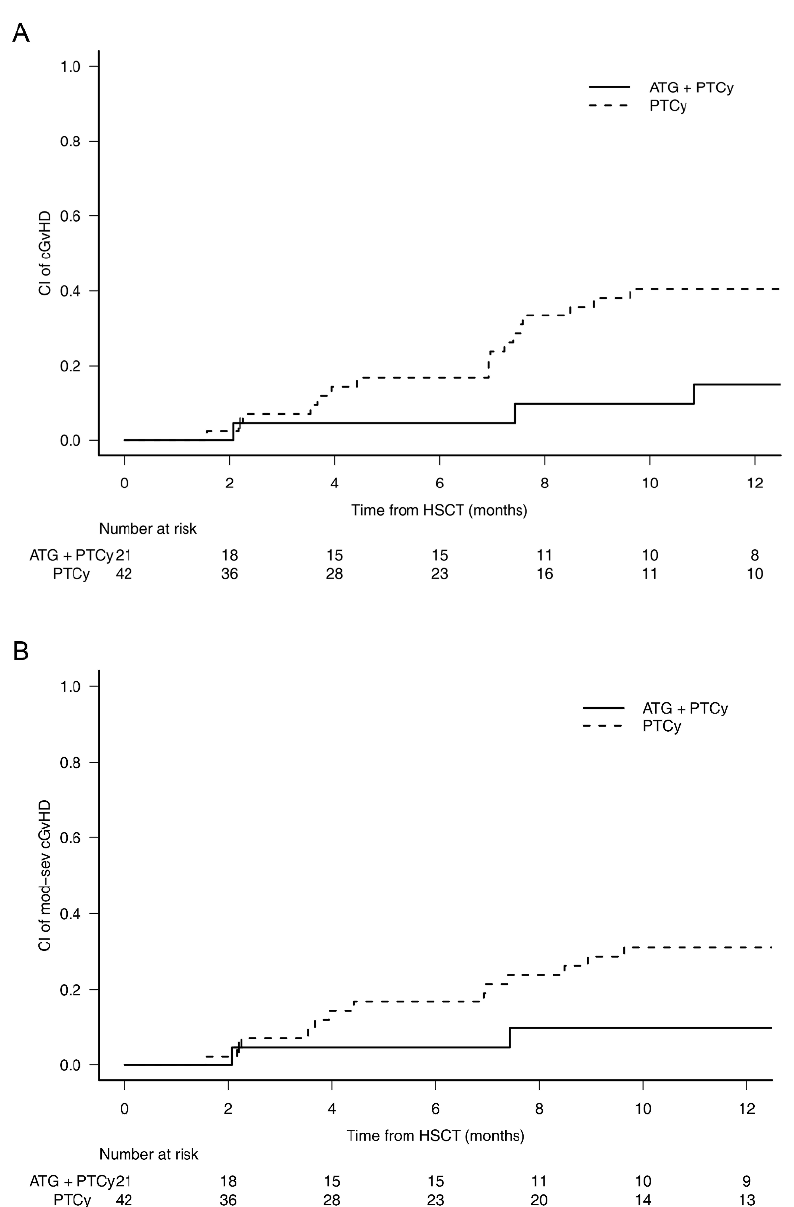
Figure 1. Chronic GvHD. Patients with a follow-up longer than 100 days were evaluated for cGvHD. ( A ) In the study group, 1-year cumulative incidence of cGvHD was 15% (95% CI 3–34) vs. 41% (95% CI 25–55) in the control group, p = 0.04. ( B ) In the study group, 1-year cumulative incidence of moderate-to-severe cGvHD was 10% (95% CI 2–28) vs. 31% (95% CI 18–45) in the control group, p = 0.07. Abbreviations: PT-Cy, post-transplant cyclophosphamide; ATG anti-T lymphocyte globulin; GvHD, Graft versus Host Disease; HSCT, hematopoietic stem cell transplant.